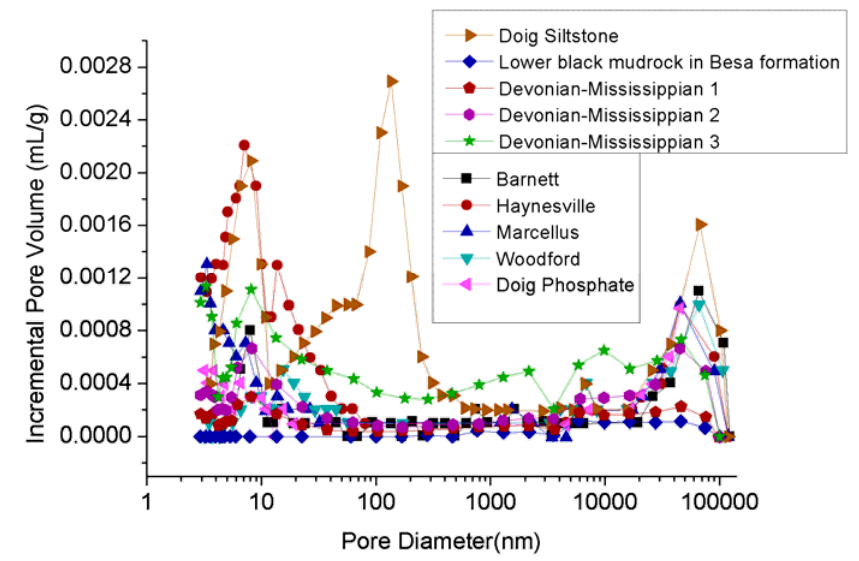
Figure 5. Pore size distribution of reservoir rock Figure 5 . Pore size distribution of reservoir rock [14,40].